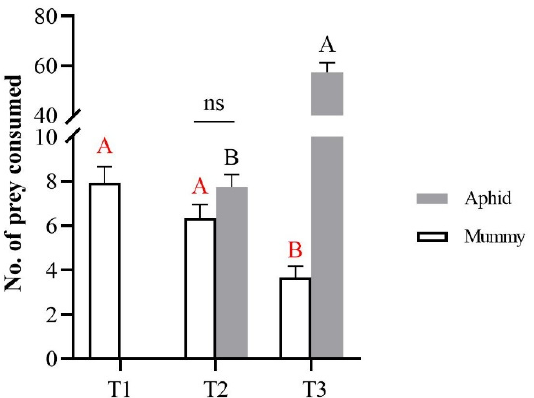
Figure 1. The number of prey (mean ± SE) consumed by Hippodamia variegata adults after four hours. T1: 10 mummies and 0 aphids; T2: 10 mummies and 10 aphids; T3: 10 mummies and 100 aphids. Different letters above columns indicate significant differences in mummy consumption under different aphid densities, “A, B” of red color indicate a comparison between consumption of the mummies and “A, B” of black color indicate a comparison between consumption of the aphids ( p < 0.01, Tukey’s HSD test); “ns” denotes no significant difference between the consumption of aphids and mummies with 10 aphids and 10 mummies per dish ( p > 0.05).